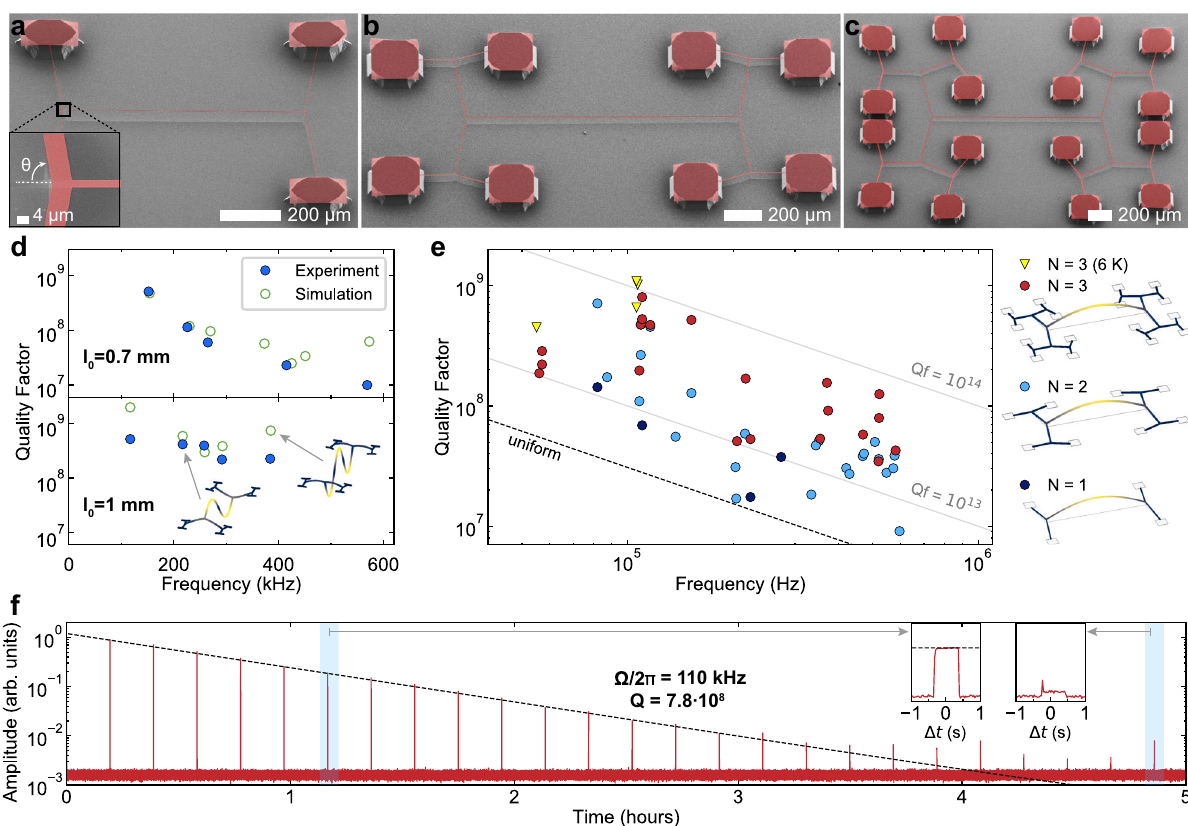
Fig. 2 Binary tree nanobeam resonators. a – c Scanning electron micrographs of binary tree beams with varying branching number, N . Si 3 N 4 is shown in red, Si in gray. Inset of a : close-up of a bifurcating junction. d Q versus mode order of two resonators with N = 3. Top: θ = 78°, r l = 0.65, and l 0 = 0.7 mm. Bottom: θ = 83°, r l = 0.45, and l 0 = 1 mm. Blue circles: measurement results. Green open circles: fi nite element model prediction. Insets show simulated mode shapes. e Survey of fundamental mode quality factors of binary tree beams. Colors differentiate N ; circles indicate room temperature measurements, triangles correspond to measurements at about 6 K. The legend shows the evolution of the mode shape as a function of N . Dashed line: predicted fundamental mode Q of a uniform beam with the experimentally observed intrinsic dissipation. f Sample ringdown trace (red) and exponential fi t (black). The measurement was performed at room temperature. Inset: close-ups of two intervals when the measurement laser was on ( ∼ 0.7